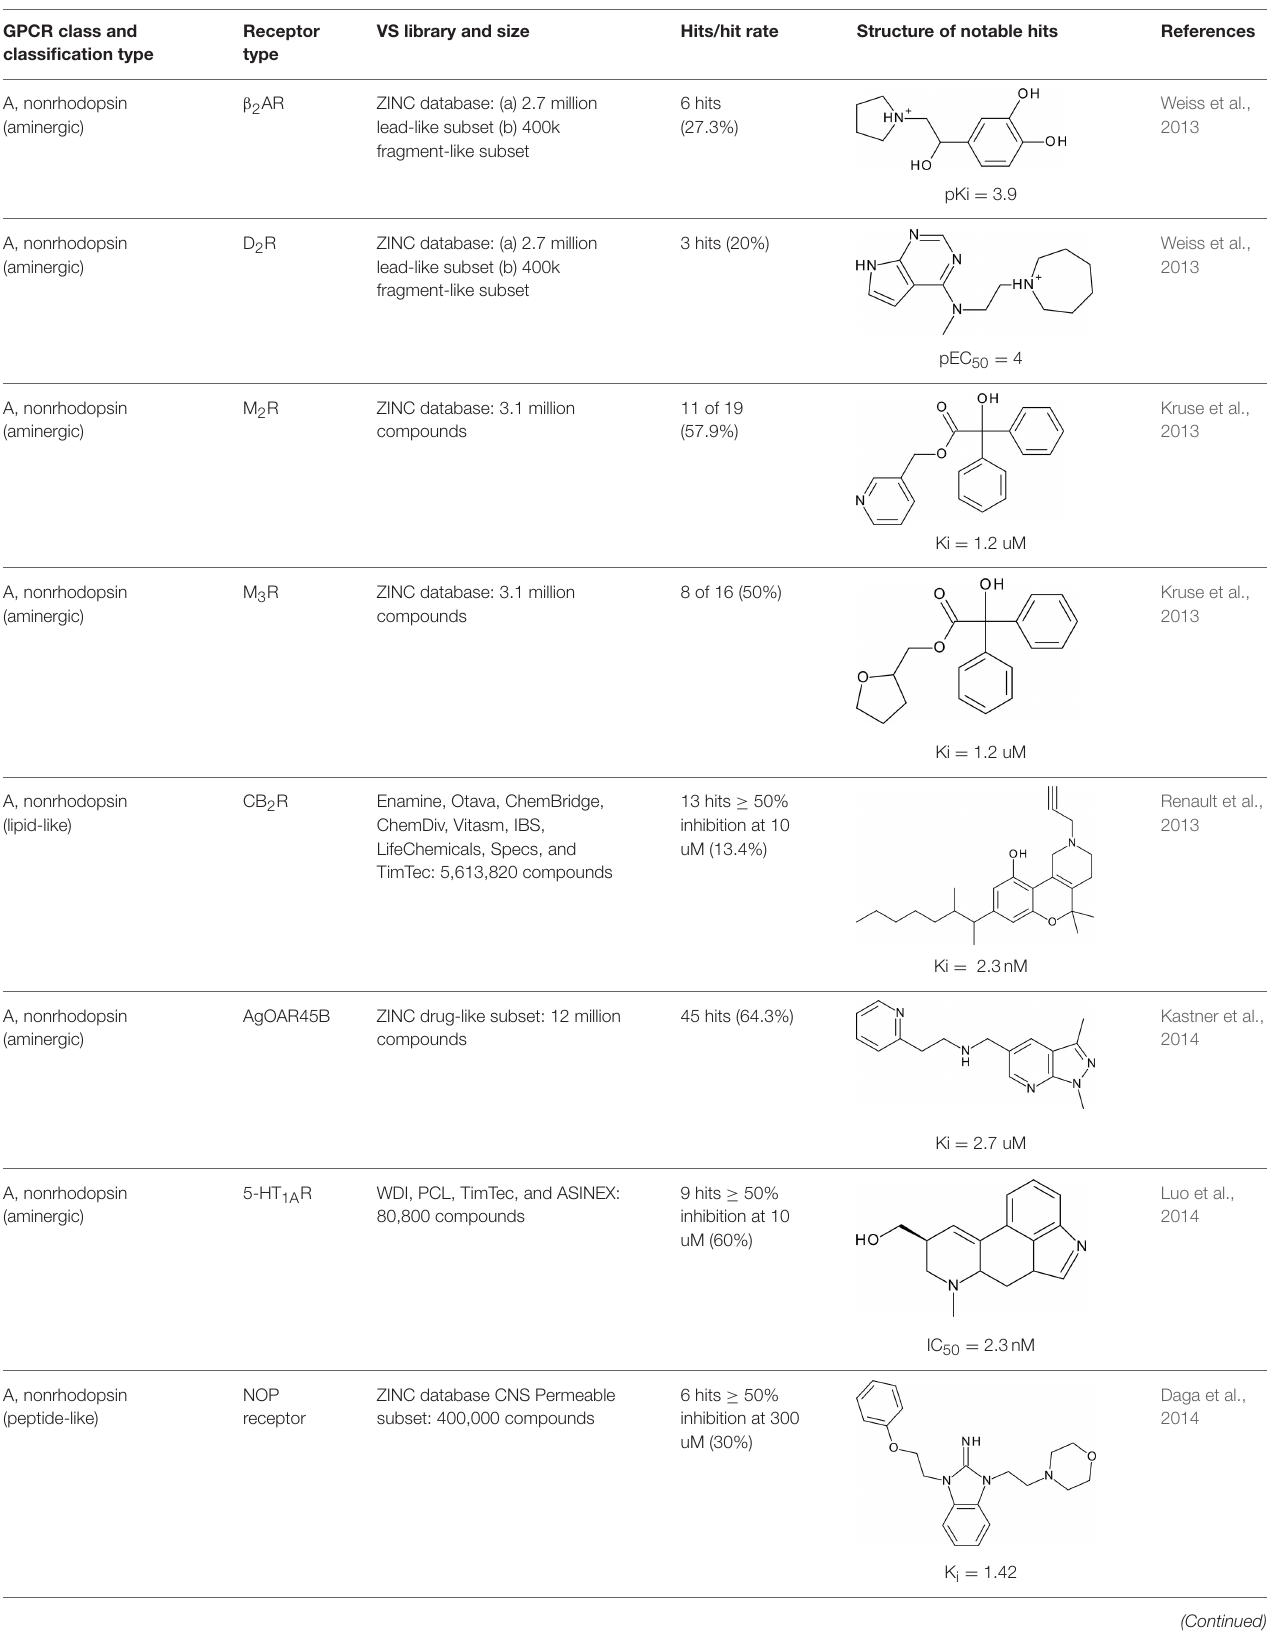
TABLE 1 | Key details of GPCR virtual screening campaigns reported in the last 5 years